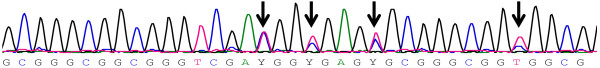
Analysis of cytosine methylation in the FMR1 promoter after treatment with 5-azadeoxycytidine (5-azadC). The arrows indicate CpGs that were partially demethylated.